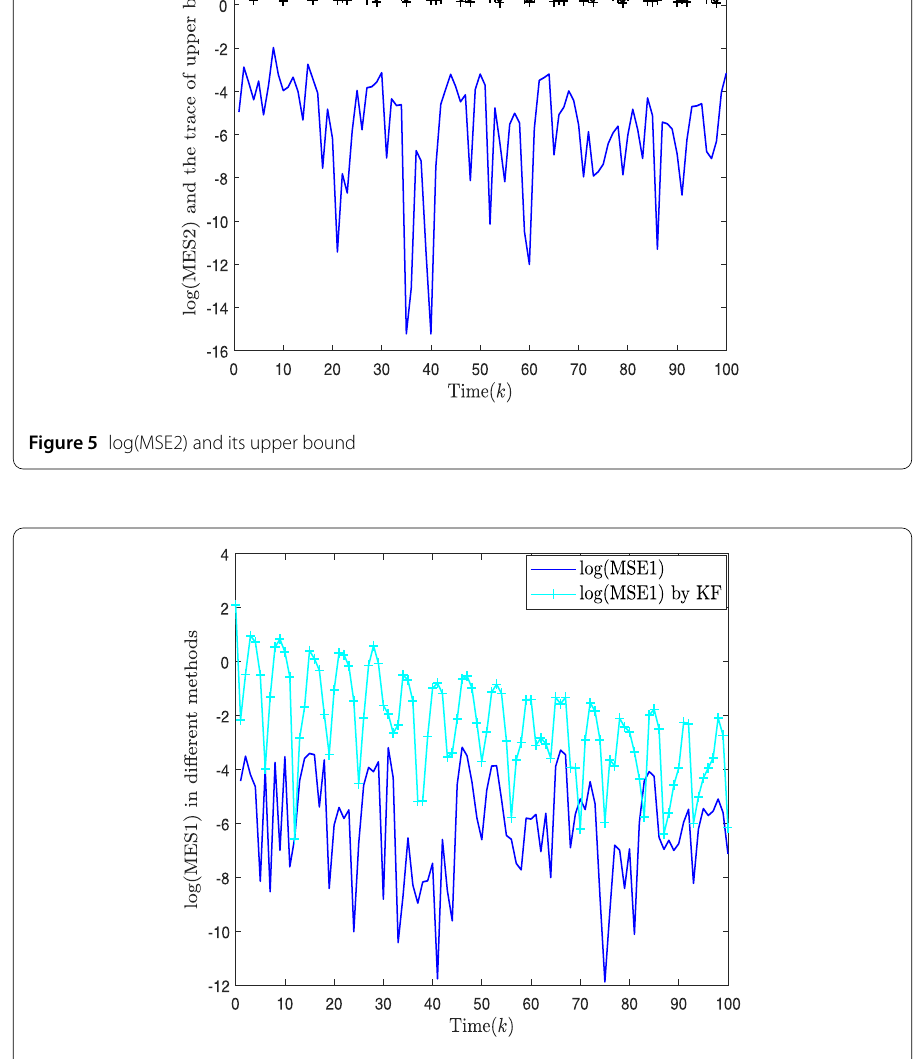
Figure 6 log(MSE1) in different